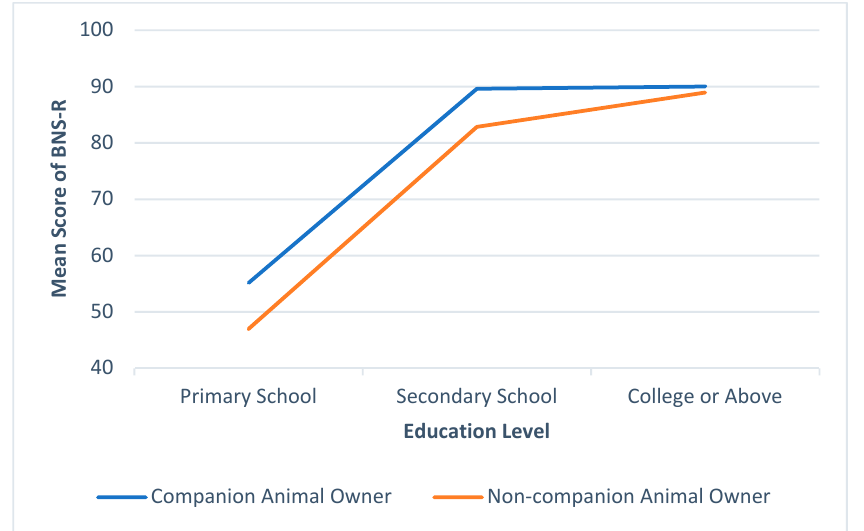
Figure 2. The comparison between owners and non-owners on BNS-R among education levels. Table 6. Descriptive statistics on BNS-R among education level by ownership